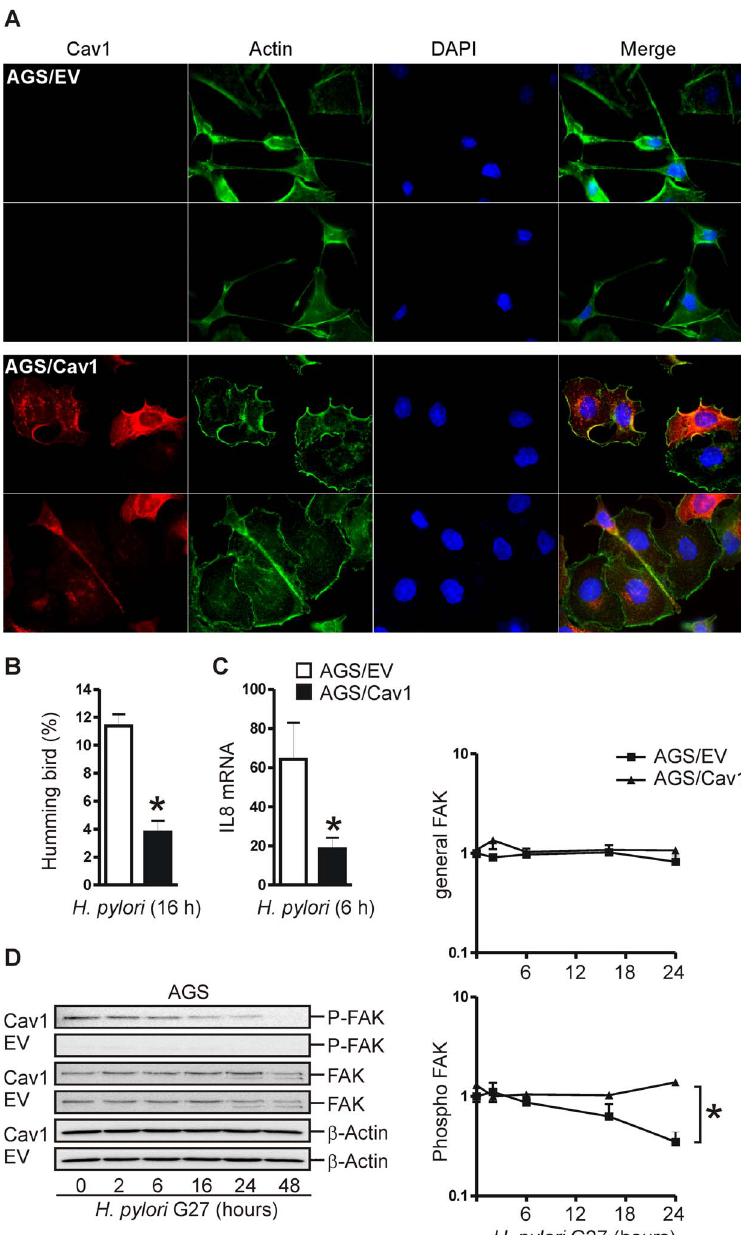
Figure 4. Cav1 protects human GC cells against CagA-induced cytoskeletal stress. (A–B) Cav1 inhibits CagA-induced cytoskeletal responses (‘‘humming bird’’). AGS clones were infected with CagA-delivery proficient H. pylori G27 (MOI=100) for 16 h and stained for immunofluorescence microscopy; green=actin (phalloidin), red=Cav1, blue=nuclei. Magnification 6 630. Note the needle-like projections of AGS/EV cells compared to spread-out epithelial AGS/Cav1 cells. Representative images (A) are shown above the quantitative analysis (B). Morphologies of all cells ( . 10 cells/per field; total of 10 fields, n=3 experiments) were counted and calculated in % ‘‘humming bird’’ 6 S.E. compared to the total cell number; *p=1.1 6 10 2 8 AGS/Cav1 versus AGS/EV. (C) Cav1 inhibits H. pylori -induced production of IL8 mRNA. Cells were treated as in (A) for 6 h. CT- values from RT-qPCRs were normalized to b2M and presented as mean 6 S.E. (n=3 per clone); *p=0.0176 AGS/Cav1 versus AGS/EV. (D) AGS/Cav1 cells have enhanced protein levels of phosphorylated (abbrev. P-) focal adhesion kinase (FAK), which promotes cell adhesion and spreading (see also Figure S2 ), thereby opposing CagA-induced cytoskeletal stress. Representative Western Blots (WB) from total cell lysates (left) are show together with a quantitative summary (right). O.D. values from bands in gels were calculated as -fold 6 S.E. (n=3) compared to time point 0 (uninfected cells); * p=0.0012 AGS/Cav1 versus AGS/EV. doi:10.1371/journal.ppat.1003251.g004 38 6 9 WT mock;*p =0.0081; n =15 per group) as compared to MKN45, and MDCK cells were infected for 3 days with CagA- the uninfected WT mice ( Fig. 9A ). delivery incompetent SS1 ( Fig. 9B ) or CagA-proficient G27 ( Fig. 9C ) H. pylori strains. In all cell lines, a robust reduction of Similar results were obtained from in vitro studies. Two different Cav1 mRNA expression (by 62 to 85%; H. pylori versus mock; human GC cell lines with endogenous Cav1 expression, N87 and